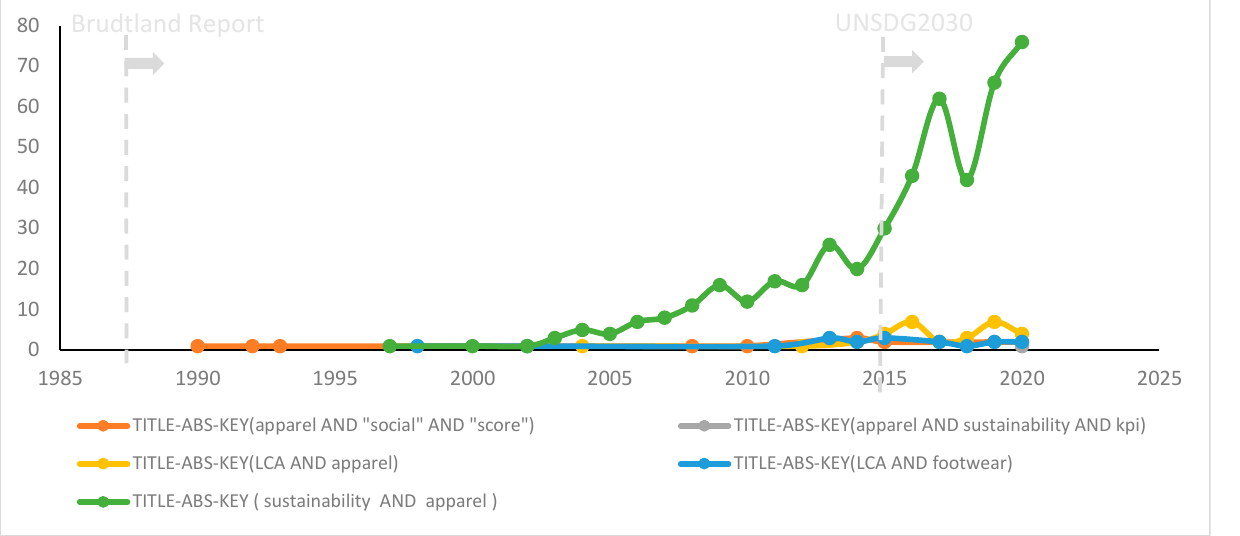
Figure 3. Query results from the Scopus database.